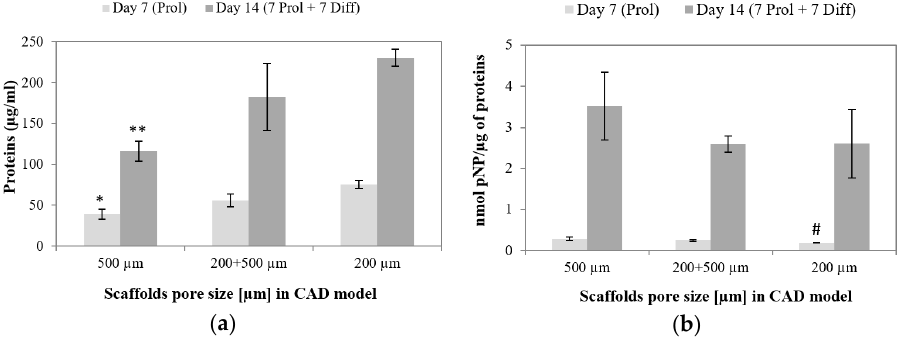
Figure 19. ( a ) Total protein concentration (TPC); and ( b ) ALP activity normalized to TPC after 7 days of culture in expansion medium (light grey) and additional 7 days of osteogenic differentiation (dark grey). *significantly lower than 200 µm pore scaffolds at day 7; **significantly lower than 200 µm and bimodal pore scaffolds at day 14; #significantly lower than 500 µm pore scaffolds at day 7.